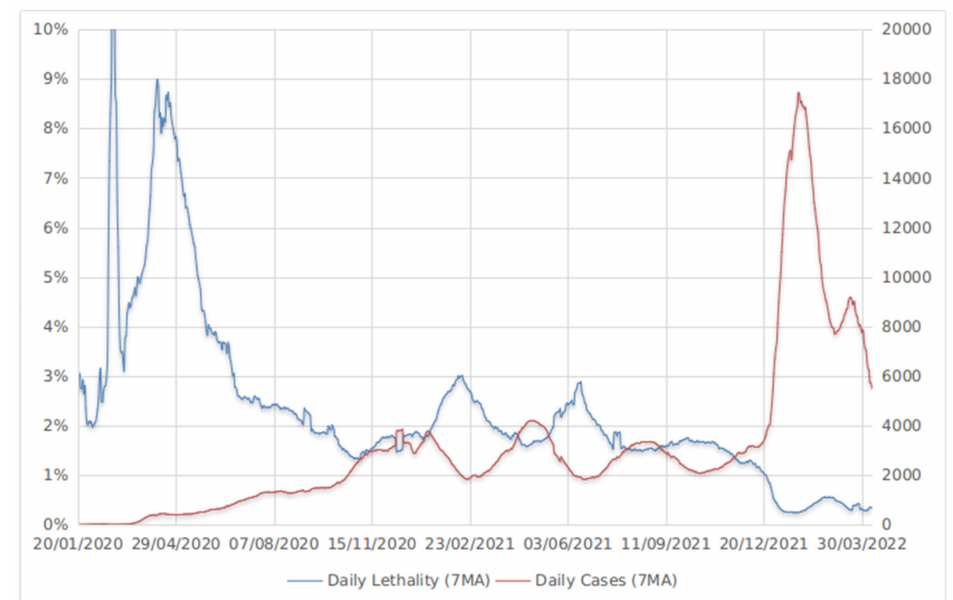
Figure 6. Fluctuations of a 7-day moving average for daily lethality and daily COVID-19 cases; data obtained from